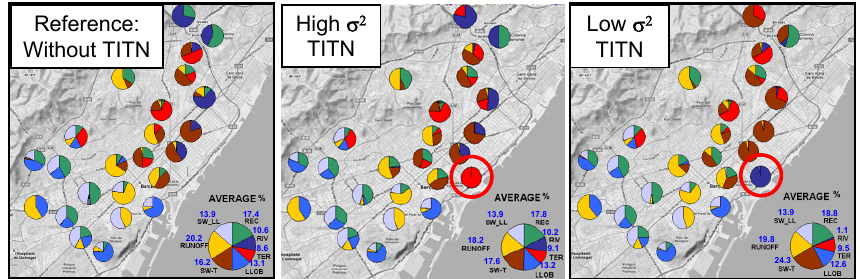
Fig. 3. Sensitivity of mixing results to the treatment of an outlier (TITN, identified with a red ring in the center and left plots). All computations are performed with 12 species, 24 or 25 wells and 8 recharge sources. Results obtained omitting the TITN well (left) are similar to those obtained assigning a very large variance to this well (center), except for TER supply water. But they are very different from the results obtained with low (same as Frigo well) variance, shown in the right graph. TITN well is not considered for the average